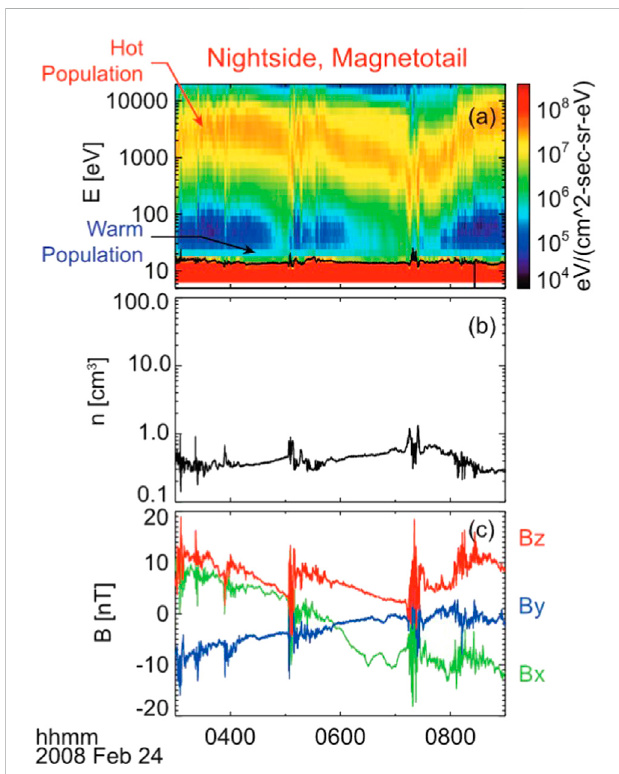
FIGURE 5 THEMIS D observations through the nightside magnetosphere of (A) electron energy spectra, (B) electron number density, and (C) magnetic fi eld measurements in GSM coordinates. The spacecraft potential of ~10 V is indicated by the black line (Walsh, et al.,